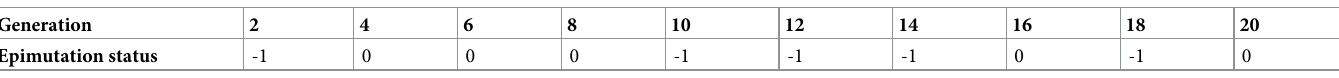
Table 4. Y65B4BL.7 Chromatin-based epimutation status over 20 generations in Lineage A.